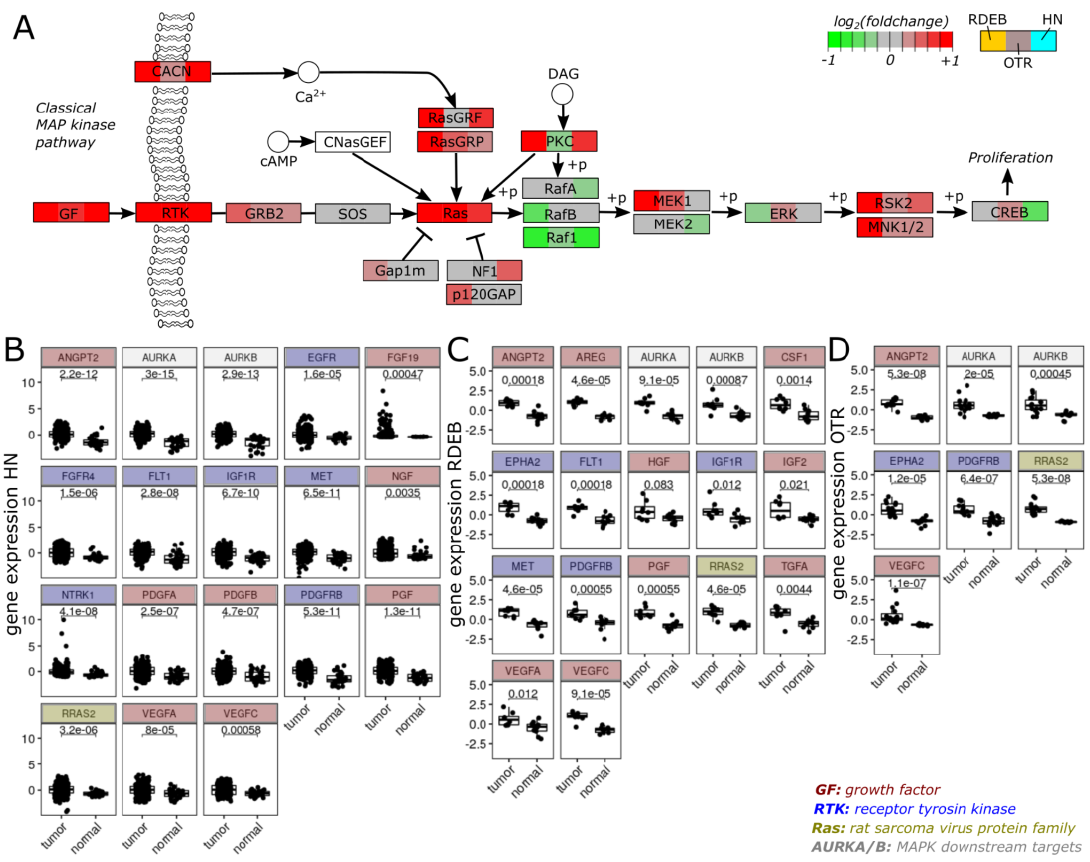
Figure 3. MAPK signaling activity. ( A ) Gene expression patterns of major classical MAP kinase pathway components (derived from KEGG pathway hsa04010). Node colors (green: down-regulated, red: up-regulated in tumor) illustrate relative gene expression levels (log2 foldchange of tumor vs. normal) in three sub-compartments (left box: RDEB, center box: OTR, right box: HN). In the case where the nodes represent multiple genes, e.g., GFs, the gene with the highest foldchange is visualized for the corresponding tumor entity. ( B – D ) Boxplots show gene expression of MAPK pathway members in ( B ) HN-, ( C ) RDEB- and ( D ) OTR-data sets belonging to functional class GF, RTK, RAS homologues, or are considered as downstream targets of MAPK signaling. Normalized counts (RDEB, HN) or intensity signals (OTR) were log2 and z-transformed to present the data on a common scale. Non-parametric, unpaired Wilcox test was applied to test significance.